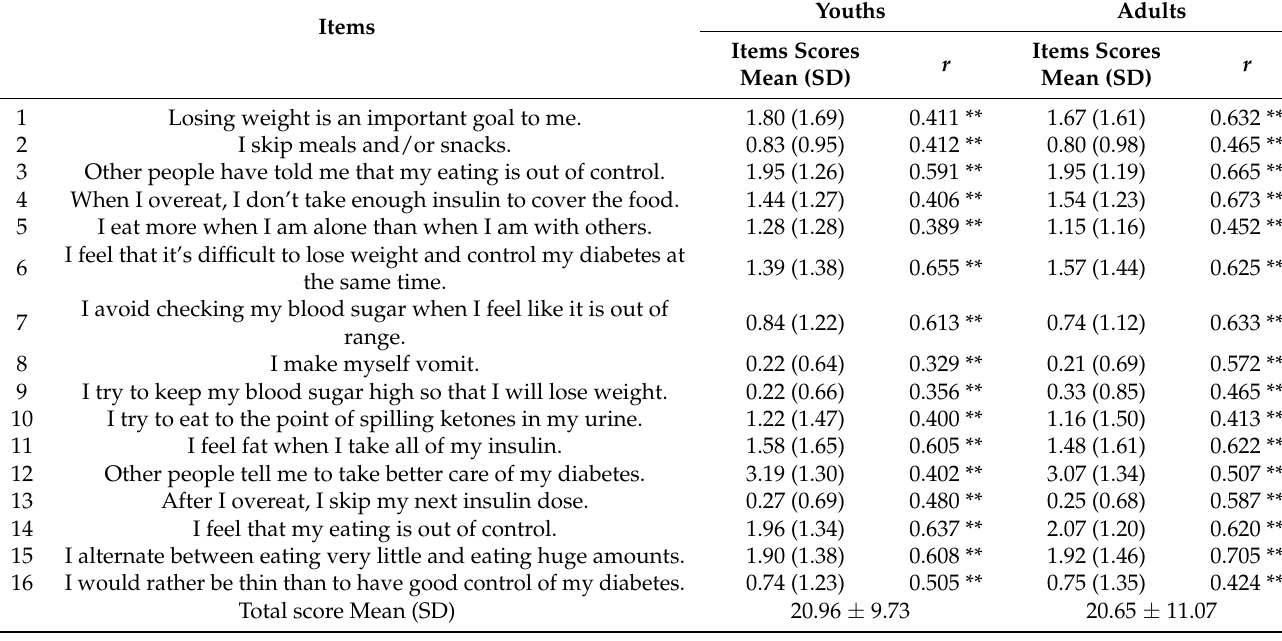
Table 2. The correlations between items and total scores of C-DEPS-R of youths ( n = 89) and adults ( n = 61). Items